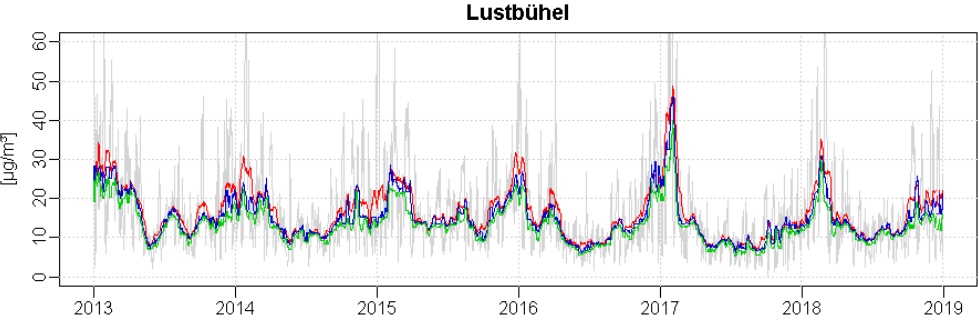
Figure 3. Background load (BGL) of three potential background stations using either the mean (red), the median (blue) or the 40th percentile (green) of the 30-day period for calculation.